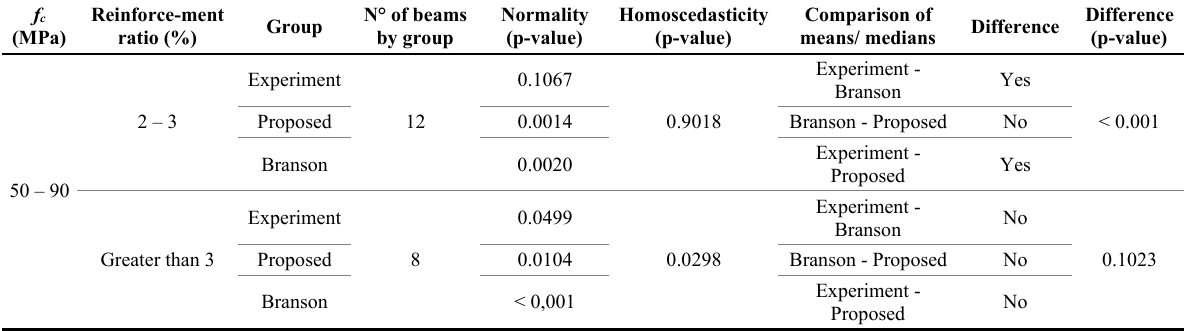
Table 3. Beams analysis with f c from 50 to 90 MPa with reinforcement rate from 2% to 3% and reinforcement rate greater than 3%. f c Reinforce-ment (MPa) ratio